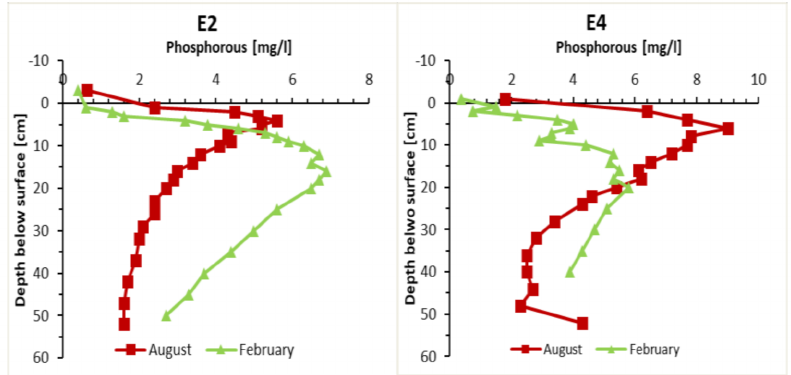
Figure 9. Phosphorous pore water profiles at locations E2 and E4 determined in August 2018 and